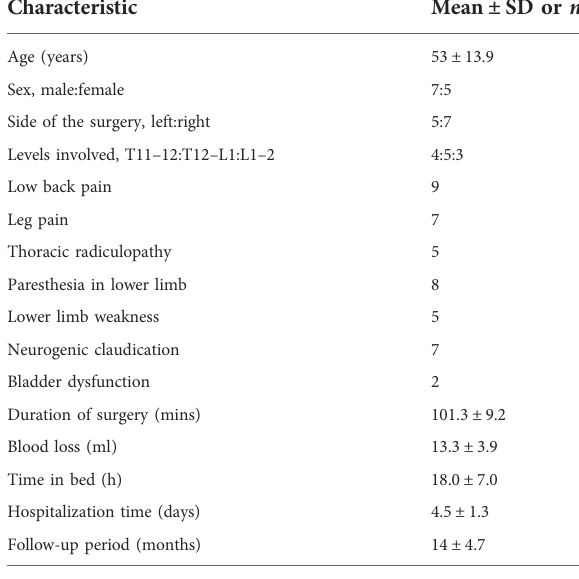
TABLE 1 Demographic fi ndings of the study patients ( n